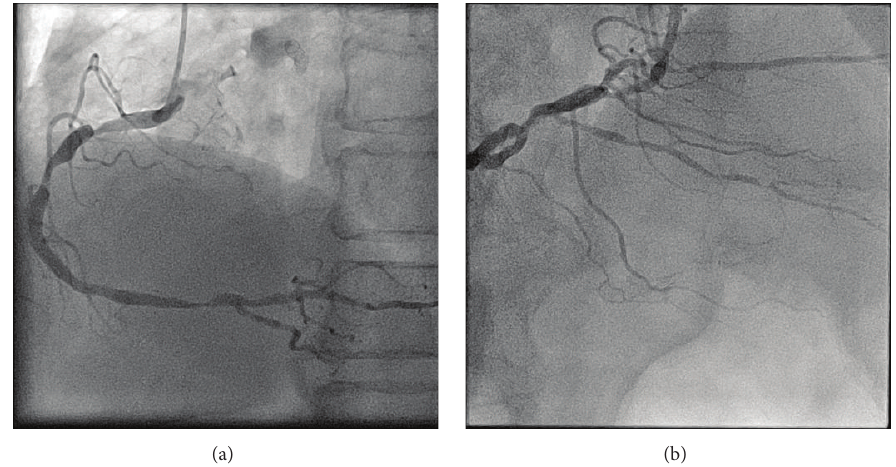
Figure 1: (a) Left anterior oblique view of the right coronary artery. There are three tandem stenoses. (b) Cranial view of the right coronary artery. There are several stenoses in the posterior descending branch and atrioventricular branch.